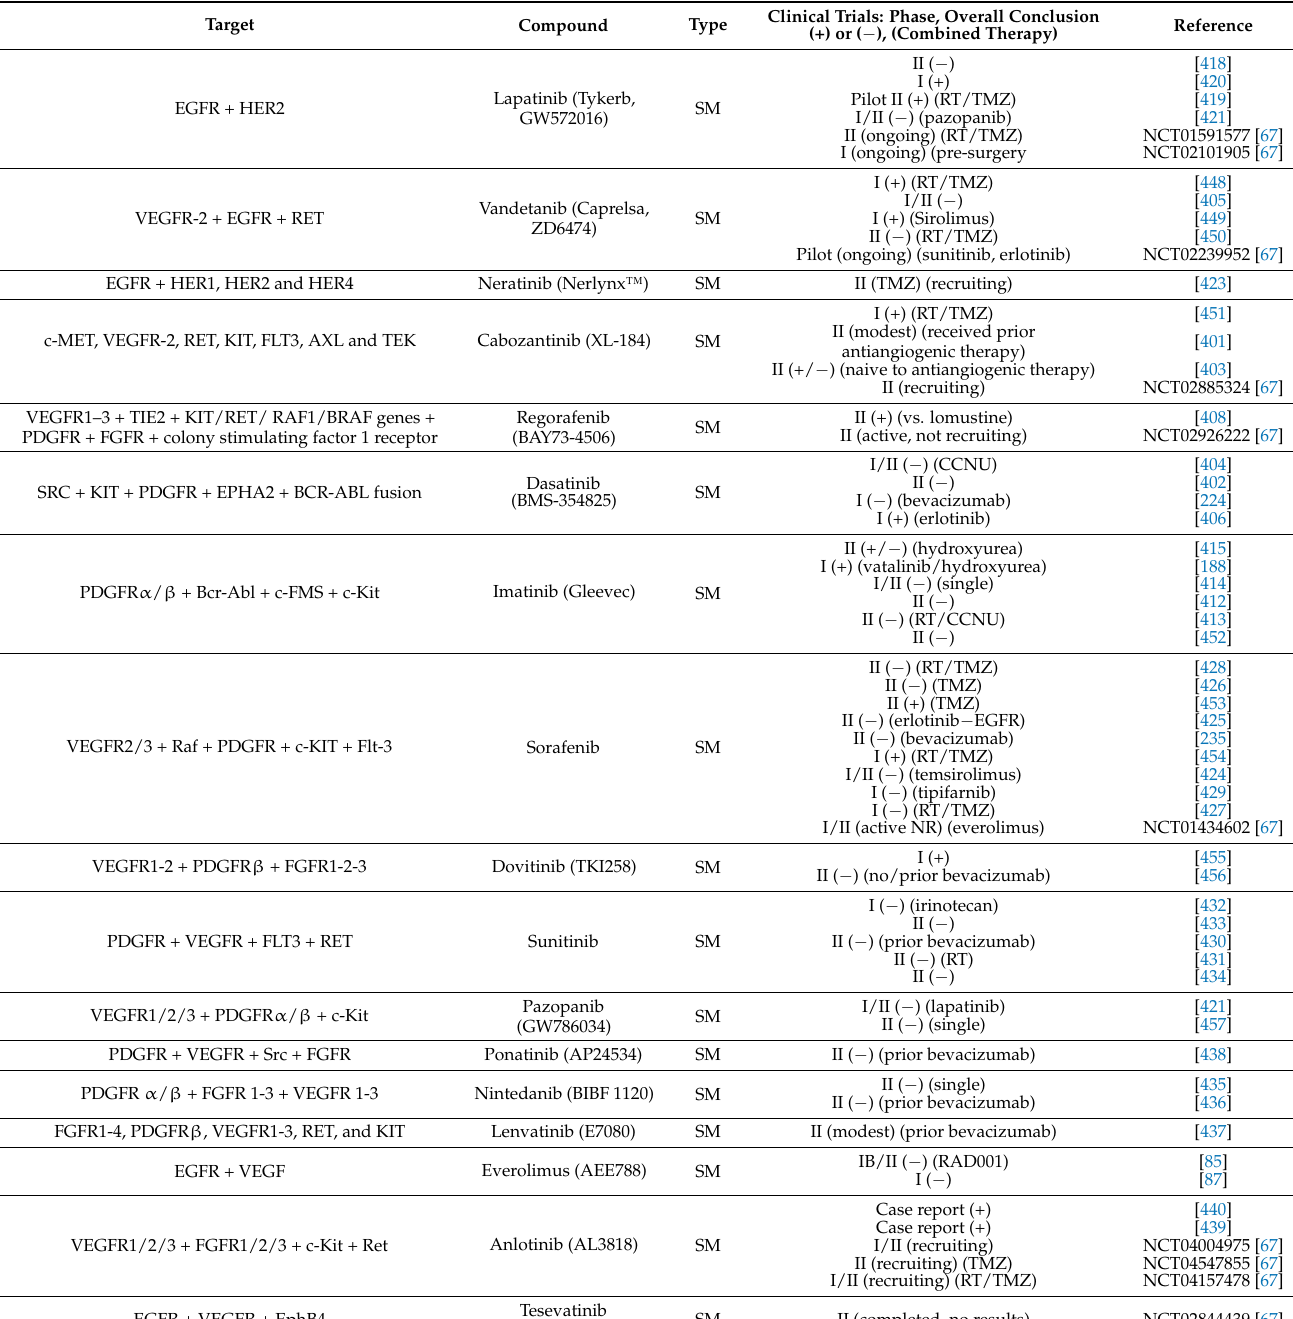
Table 9. Clinical trials on single agent multi-kinase inhibitors for GB